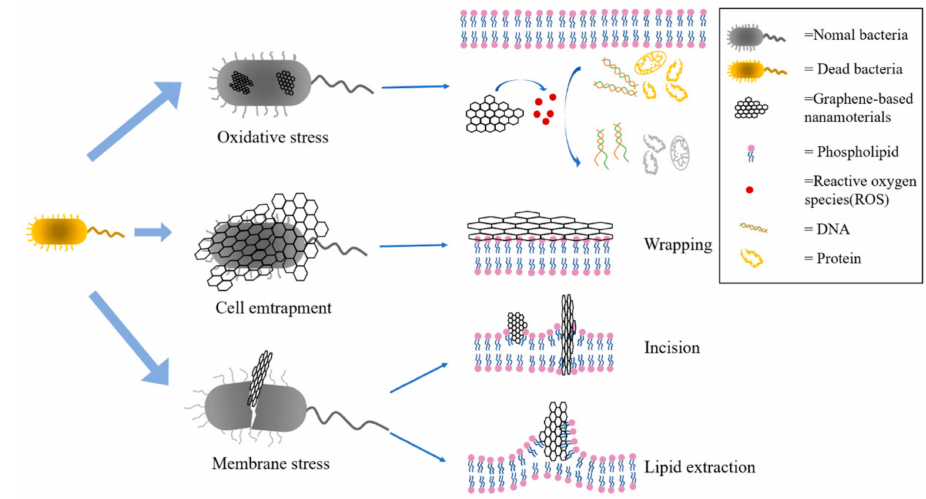
Figure 7. Antibacterial